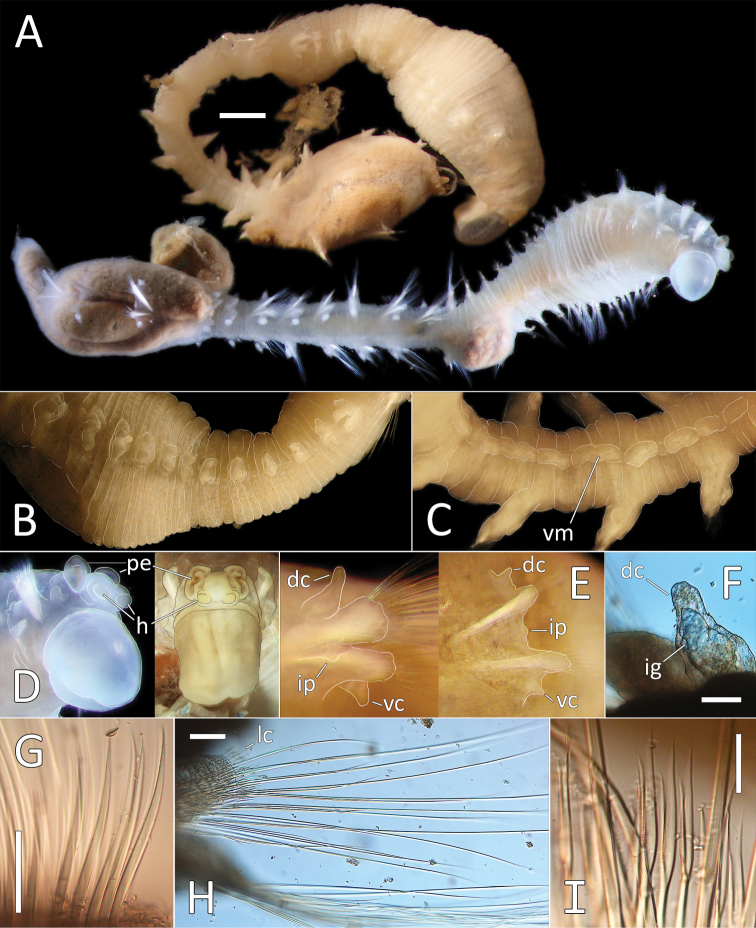
Oligobregma
whaleyi sp. nov. holotype (specimen NHM_822). A Lab (upper) and live (lower) images, whole specimens [lab image] B Lab image, mid-body segments and annulation C Lab image, ventral midbody (vm = ventral midline) D Live (left) and lab (right) images of prostomium (pe = peristomial ring, h = prostomial horns) E Lab images, midbody and posterior parapodia, chaetigers 15 (left) and 24 (right) (dc = dorsal cirrus, vc = ventral cirrus, ip = interramal papilla) F Lab image, detail of dorsal cirrus and internal gland (dc = dorsal cirrus, ig = internal gland) G Lab image, detail of notopodial spines on chaetiger 1 H Lab image, detail of capillary chaetae (lc = lyrate chaetae) I Lab image, detail of lyrate chaetae. Morphological features in plates B–D, F, G, H have been outlined with a fine white or black line to improve clarity of those features. Scale bars: 1 mm (A); 100 μm (F–H); 50 μm (I).